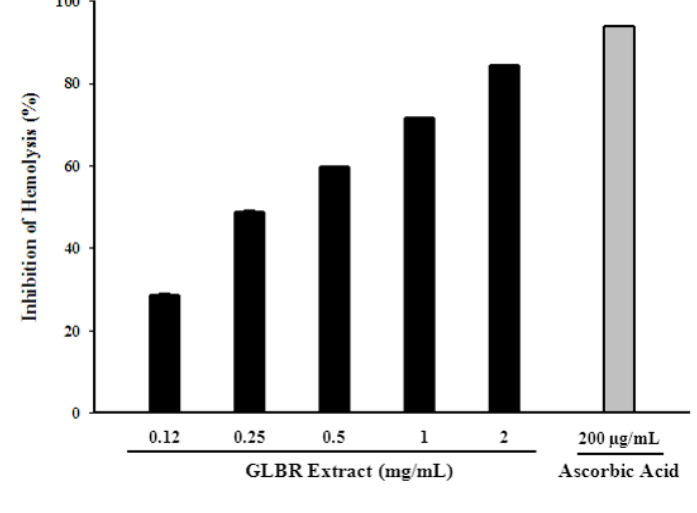
Figure 1. Hemolysis inhibitory activity of Ganoderma lucidum grown on germinated brown rice (GLBR)